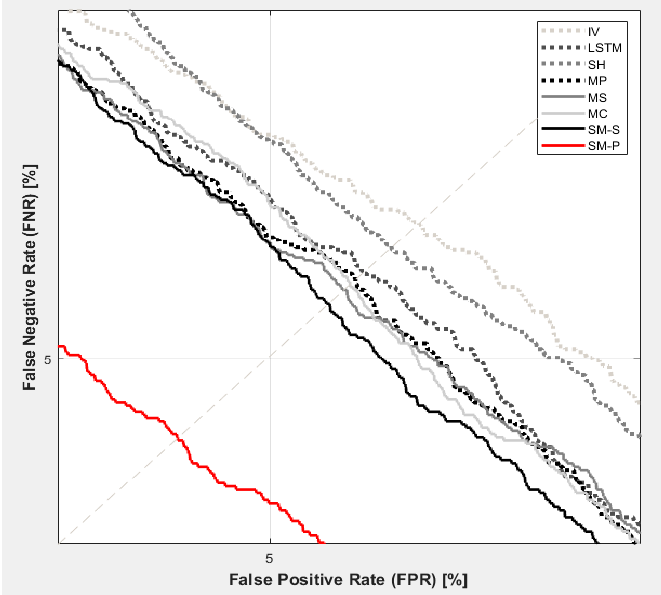
Figure 6. Detection Error Tradeoff including the baseline system of i-vector and speaker embeddings and two proposed methods.